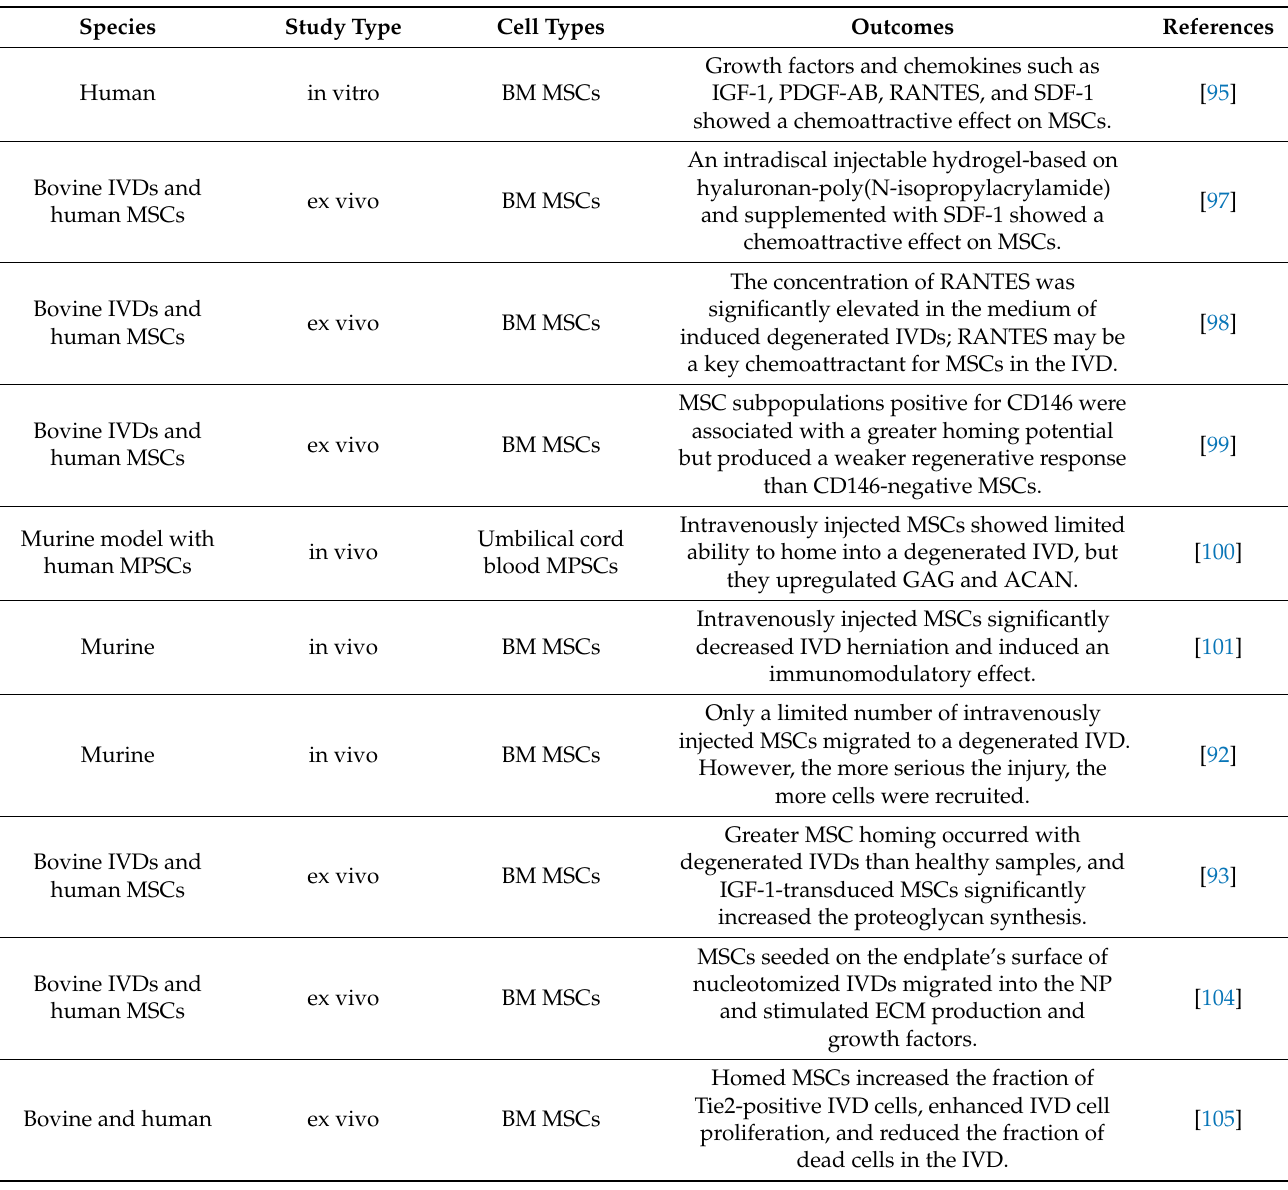
Table 3. Recent studies related to the homing capabilities of MSCs into the